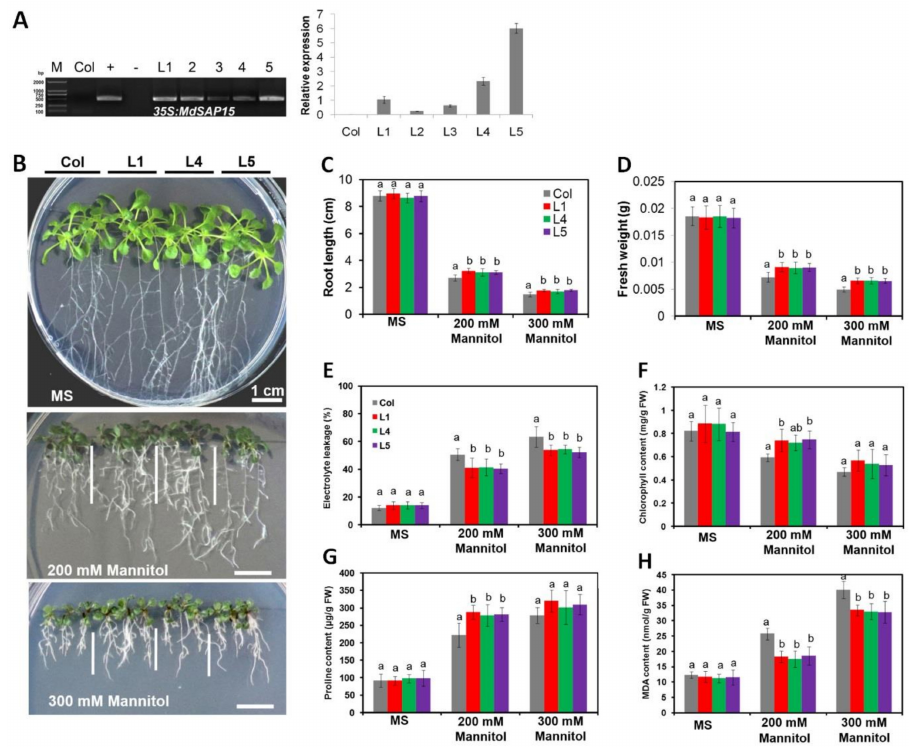
Figure 7. Overexpression of MdSAP15 in Arabidopsis increased osmotic tolerance in response to mannitol treatment. ( A ) PCR identification and relative expression analysis of MdSAP15 in Col-0 wild-type (Col) and transgenic Arabidopsis lines. M, DNA marker; − , negative control (H2O); +, positive control (plasmid DNA of 35S::MdSAP15 pRI101AN vector). Specific primers for MdSAP15 were used to detect relative expression levels of Col and transgenic Arabidopsis lines. ( B ) Representative images of “Col” and transgenic seedlings at 5 days after seeds had been cultivated for 11 days on MS medium alone (0 mM mannitol) or MS medium supplemented with 200 or 300 mM of mannitol. Bars = 1 cm. ( C ) Primary root lengths and ( D ) fresh weights of “Col” and transgenic seedlings measured on Day 5 after plants had been exposed for 11 days to osmotic stress. ( E ) Relative electrolyte leakage, and levels of chlorophyll ( F ), proline ( G ), and malondialdehyde (MDA) ( H ) in “Col” and transgenic seedlings, measured on Day 5 following treatment on MS medium with 0 mM, 200 mM, or 300 mM of mannitol for 11 d. Error bars represent SD based on three independent replicates. For ( C – H ), bars not labeled with same letters in each panel indicate values are significantly different at p < 0.05, based on one-way ANOVA and Duncan’s